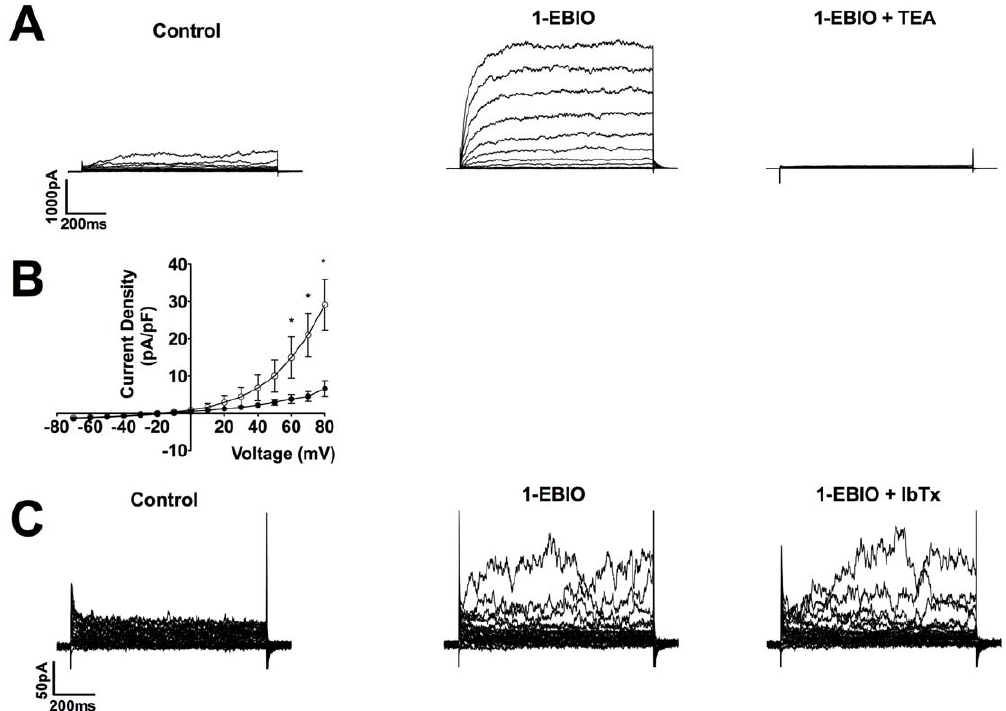
N Figure 5. Characterisation of Ca 2 + -activated K + channel openers in CPASMCs. The IK Ca and SK Ca channel activator 1-EBIO (100 m M) ) increased outwards currents in CPASMCs ( A ). Mean current-voltage relationships obtained at the end of the 500 ms voltage step in the absence ( and presence ( # ) of 1-EBIO ( B ; *P , 0.05; Two-way ANOVA followed by Bonferroni Post Hoc Test; mean 6 SEM; n=22; N=10). The 1-EBIO sensitive current was inhibited by the K Ca inhibitor TEA ( A ; 5 mM; n=2; N=2), but not the specific BK Ca inhibitor iberiotoxin (IbTx; 100 nM; C Figure 5B). Tail-currents were observed in 2 out of 22 recordings Figure 7F) was not observed following substitution of primary antibody with non-immune IgG at an equivalent concentration.